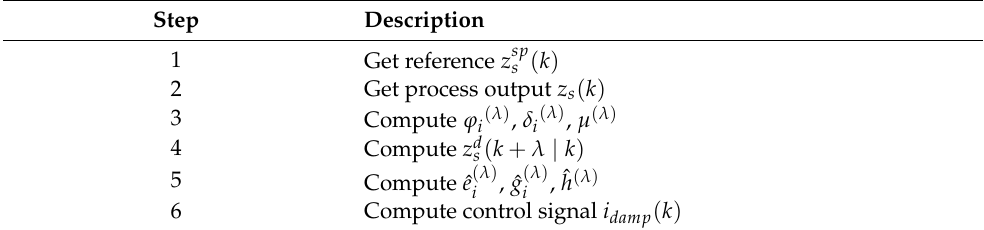
Table 1. Predictive control